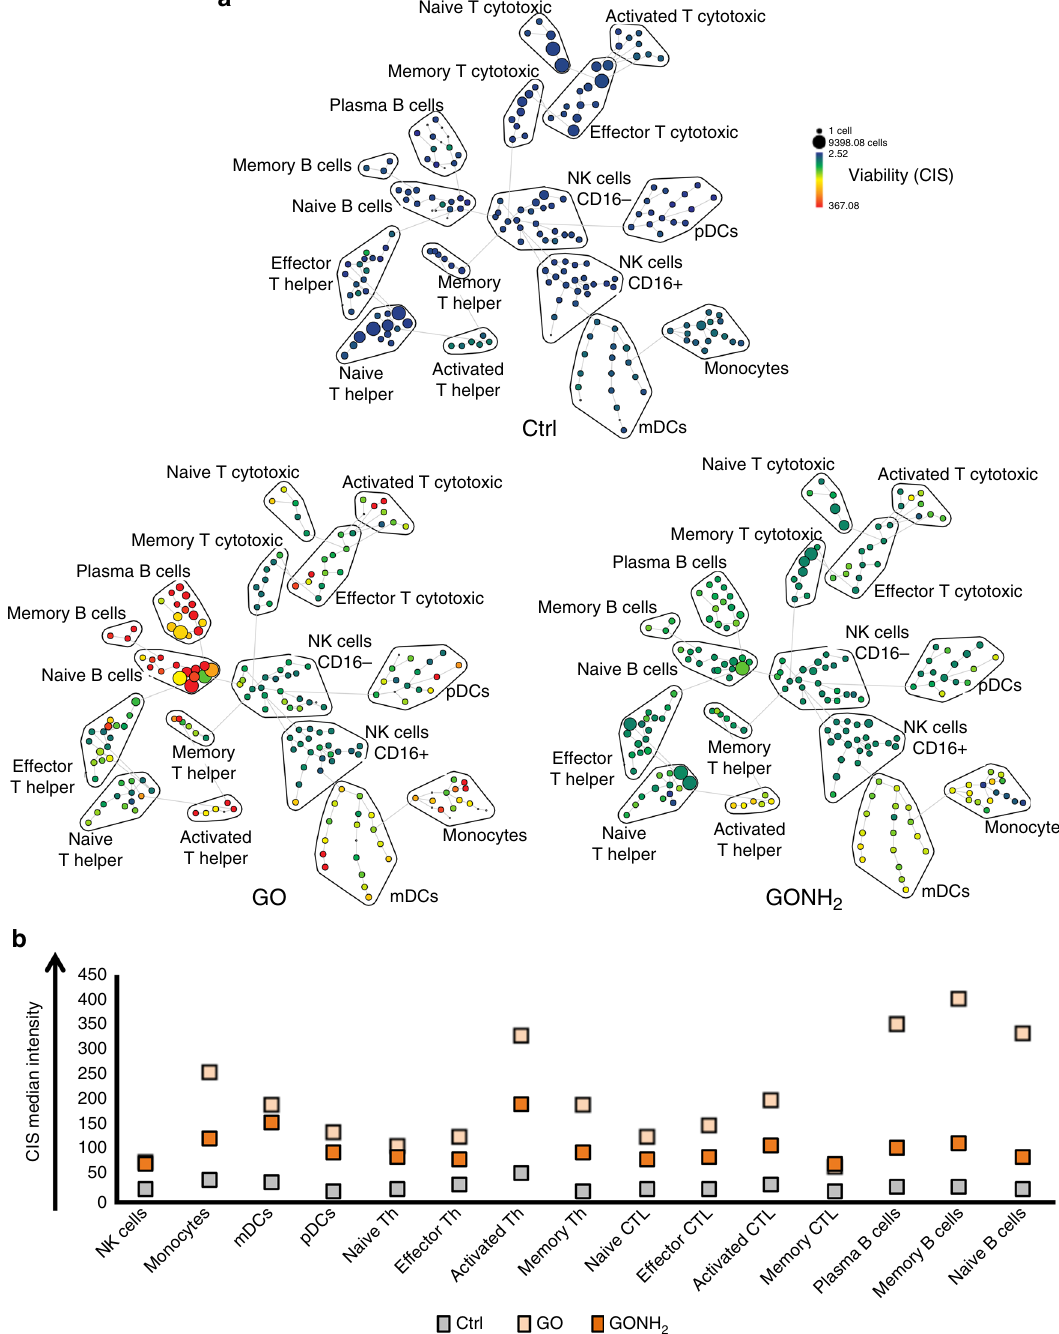
Fig. 1 Cell viability analysis using CIS reagent with CyTOF. PBMCs were treated with GO and GONH 2 at the concentration of 50 µ g ml − 1 . a The SPADE tree plots show the different gated immune cell subpopulations. The size of each cluster in the tree indicates the relative frequency of cells that fall within the dimensional con fi nes of the node boundaries. Node color is scaled to the median intensity of marker expression of the cells within each node, expressed as a percentage of the maximum value in the data set (CIS is shown). b The graph reports the CIS median intensity in all subpopulations analyzed. The analysis is made out of three experiments. CTL cytotoxic, T lymphocytes, Th T